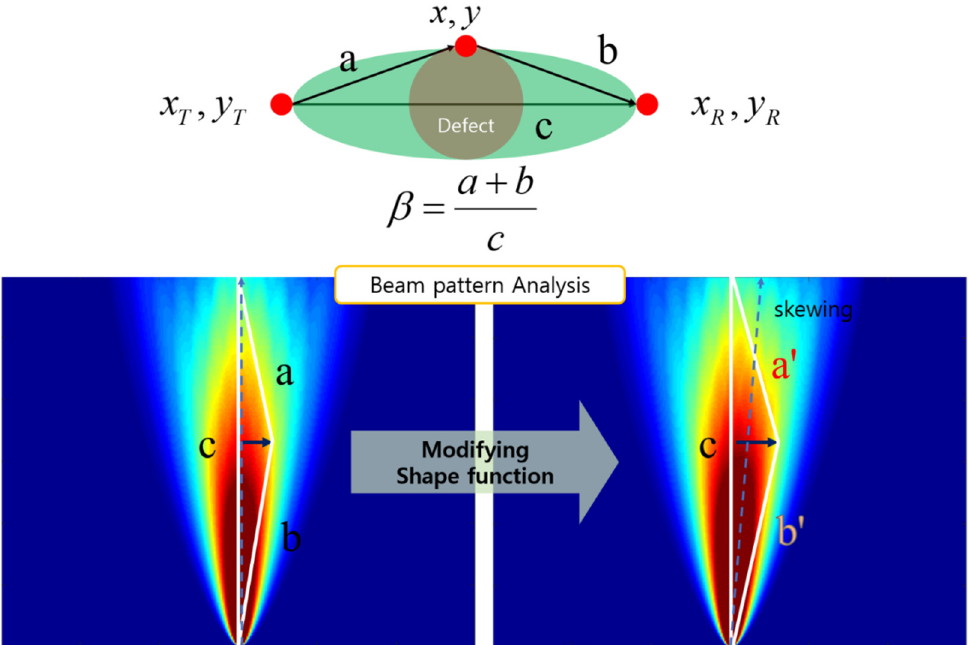
β Figure 15. Proposed technique to determine shape variable . Figure 15. Proposed technique to determine shape variable β . With the maximum range of the measurement area from the central axis of the plane to be tested, that is, the measurement flaw distance, the area corresponding to 50% of the maximum energy level of the skewed beam path was defined as the area where one beam width could be measured. The shape factor was selected accordingly based on the width formed. When the wave beam path was skewing, the path changed accordingly; therefore, the modified shape function was selected based on the distance from the central axis according to the modified path. The shape function values derived using this calculation method are shown in Figure